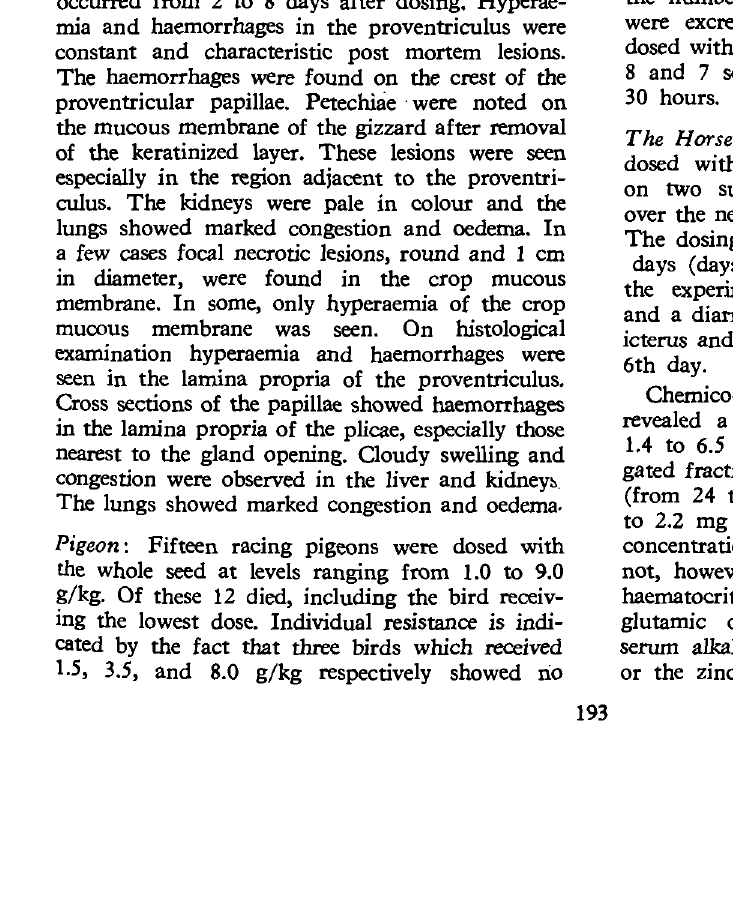
Pigeon: Fifteen racing pigeons were dosed with the whole seed at levels ranging from 1.0 to